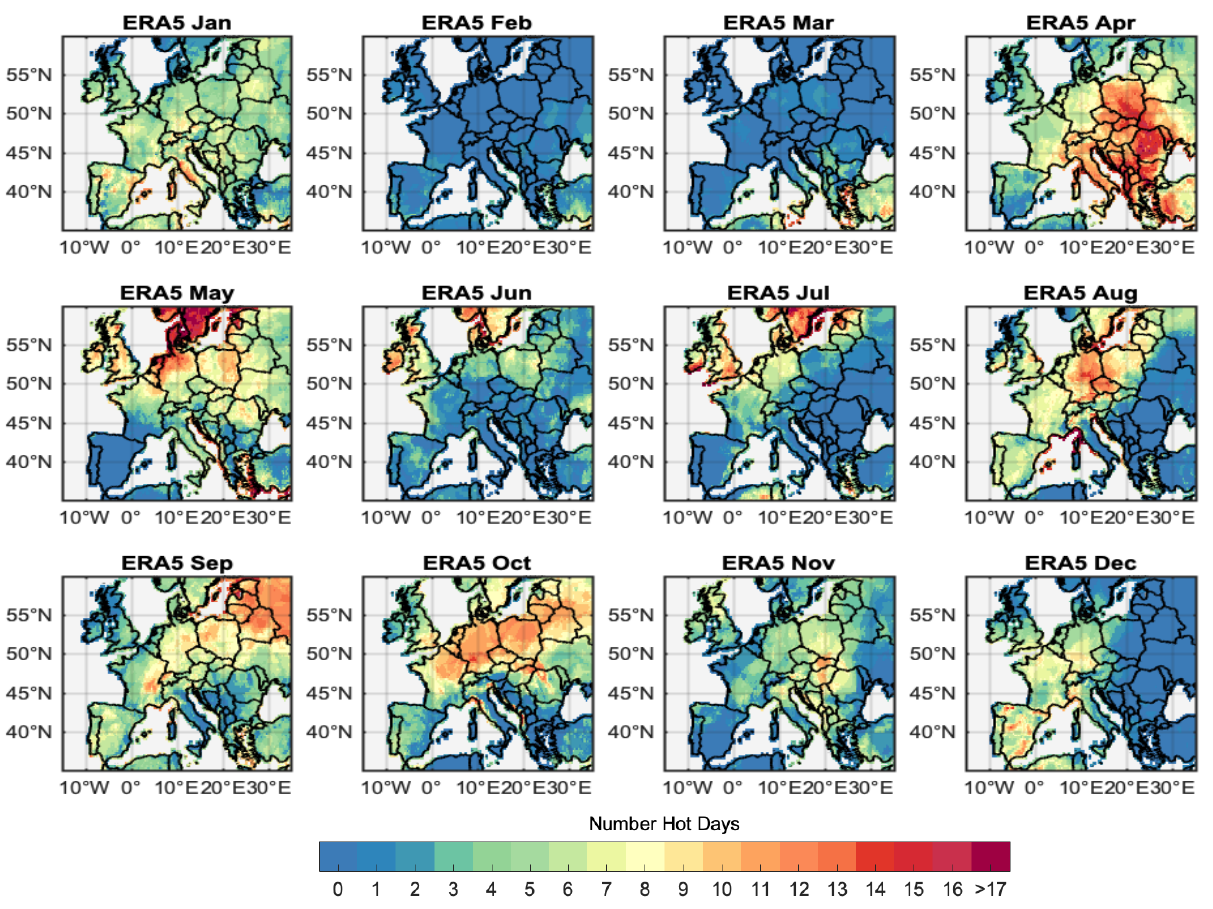
Figure 11. As in Figure 5 but considering T2m from ERA5 for 2004 – 2019.